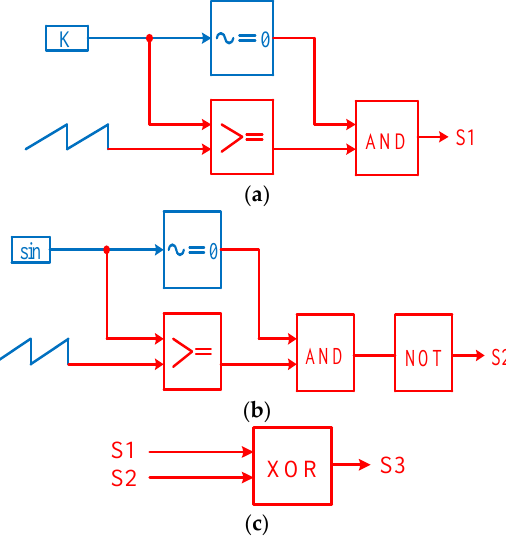
Figure 4. Control block diagram of the proposed inverter ( a ) the switch signal of S1; ( b ) the switch signal of S2; ( c ) the switch signal of S3.